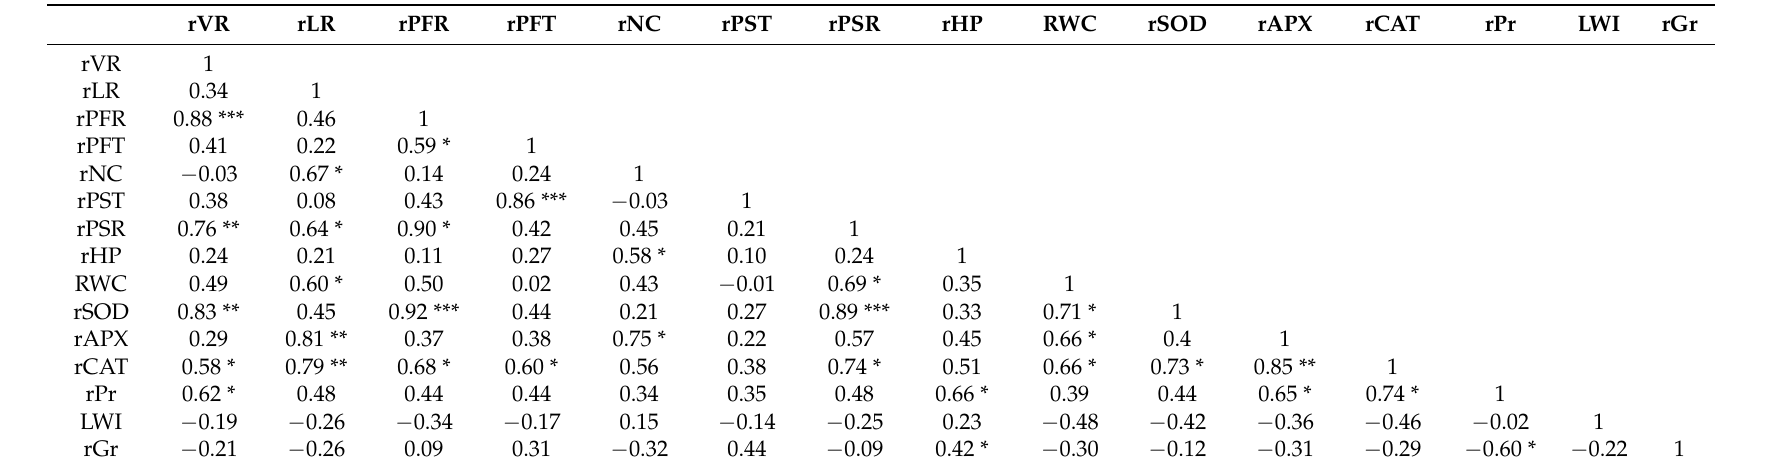
Table 5. Pearson correlation (r) between the studied